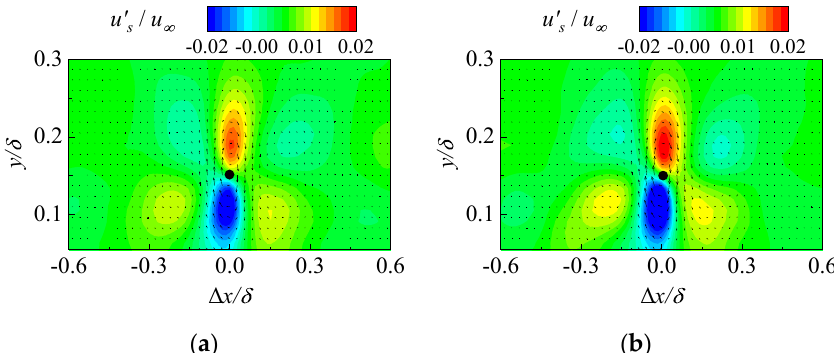
Figure 8. Conditional averaging of small-scale flow field: ( a ) None; ( b ) Control.